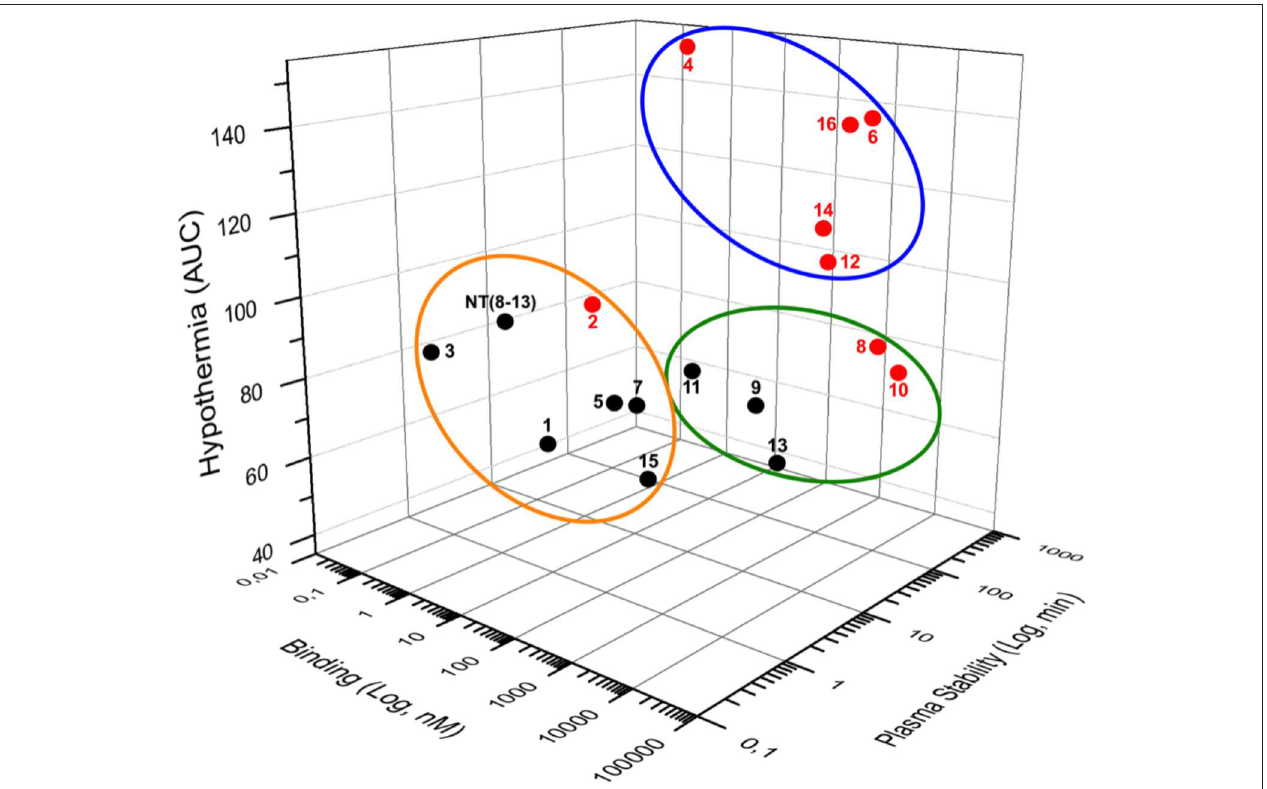
FIGURE 4 | Three-dimensional (3D) data representation. Binding on NTS1, plasma stability and hypothermia represent the three coordinates of each compound. For hypothermia, results were presented as area under the curve (AUC). Compounds carrying the reduced Lys 8 -Lys 9 bond are in red whereas non-reduced analogs are shown in black. The stable NT(8-13) analogs exhibiting a good affinity for NTS1 and inducing hypothermia are surrounded by a blue circle. The orange circle includes compounds with a good affinity for hNTS1 and short plasma half-life that do not affect body temperature. Compounds with a low affinity toward hNTS1 exerting no hypothermic action are represented with the green